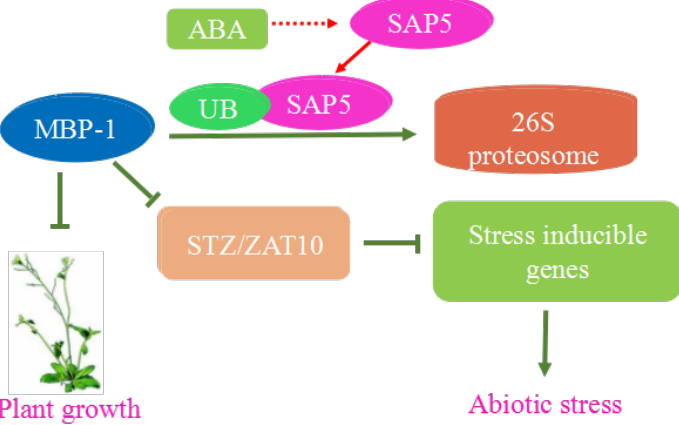
Figure 5. Hypothetical model of the action of ABA, AtSAP5 and AtMBP-1 (refer to Miyoung et al., 2013 [13]). MBP-1 suppresses STZ/ZAT10 gene expression which can respond to ABA and plant growth. ABA increases the expression of AtSAP5 which can promote the degradation of AtMBP-1 by the ubiquitin-dependent proteasome pathway. Sharp arrow represents the function of promotion and blunt arrow represents the function of inhibition. The solid line indicates that the interaction between the two is clear and the dotted line indicates that the interaction between the two is not clear.